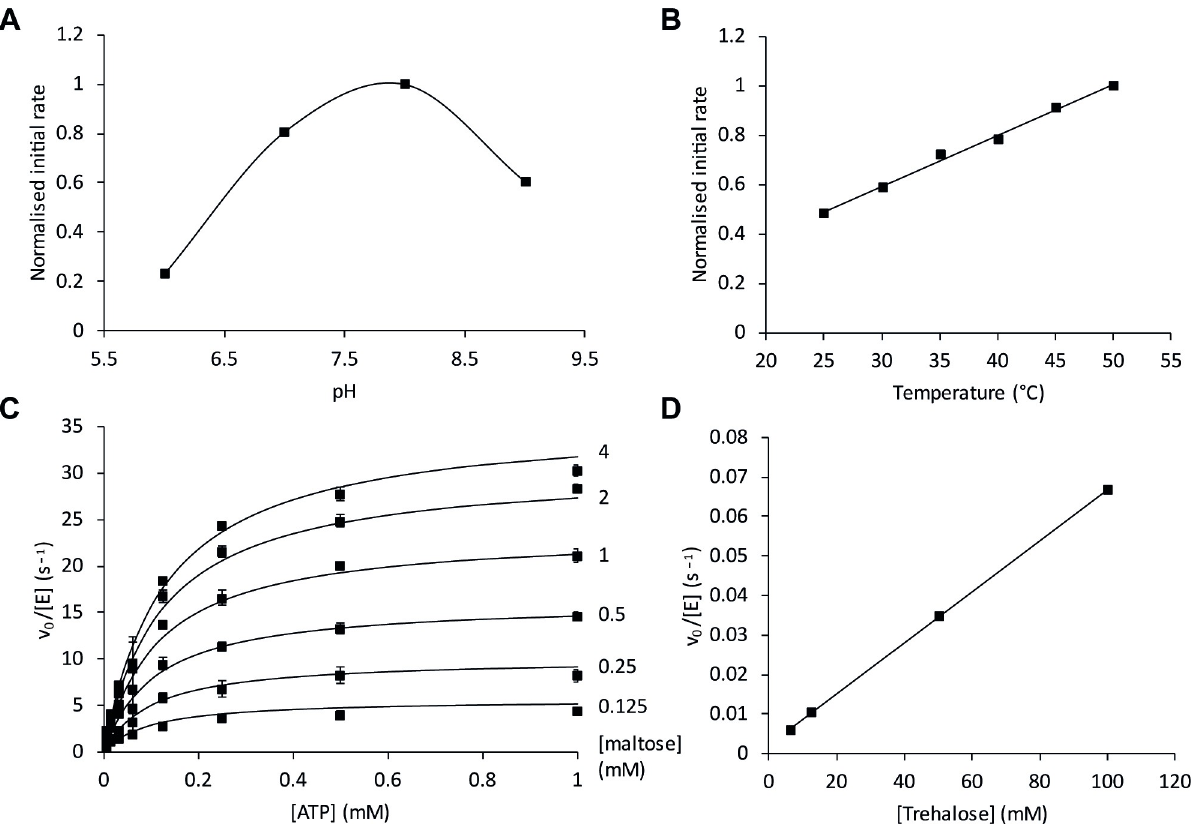
Fig 3. A-C) Dependence of PAO1 TreS/Pep2 maltokinase activity on pH, temperature, and substrate concentrations. Maltokinase activity was monitored by detecting the production of ADP using a coupled assay with maltose, phosphoenol pyruvate, pyruvate kinase, lactate dehydrogenase and NADH. A) Maltokinase activity of TreS/Pep2 with maltose and ATP was optimal at pH 8. B) Maltokinase activity increased ~2-fold linearly with temperature between 25 and 50˚C. Data points in A) and B) represent means of duplicate experiments. C) The maltokinase activity of TreS/Pep2 was determined as a function of ATP concentration with a series of fixed maltose concentrations. The smooth lines represent the fit to the data of a random order ternary complex mechanism. Data points show means of triplicate measurements and standard error. D) The activity of TreS with trehalose was monitored indirectly by detecting ADP production by Pep2 in a coupled reaction. The K m for trehalose was evidently > 100 mM.